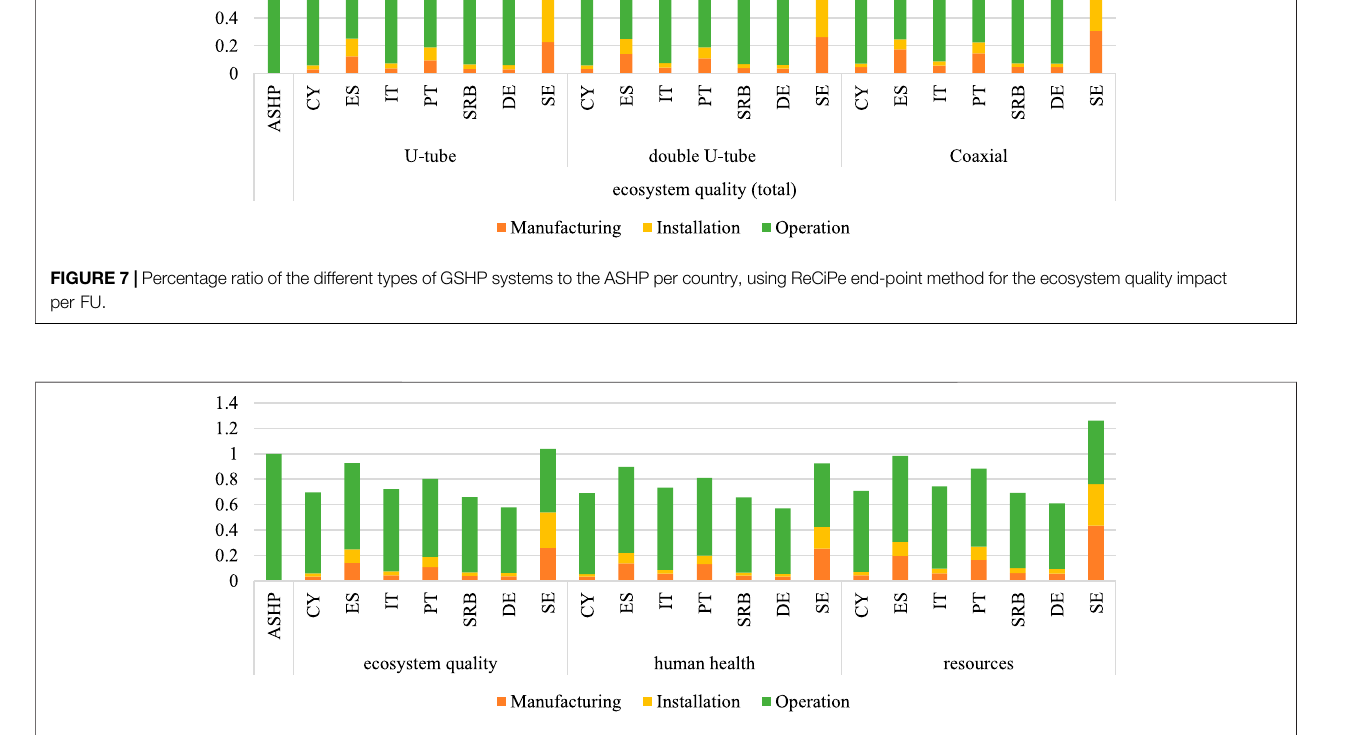
FIGURE8| PercentageratioofthedoubleU-tubeGSHPsystemtotheASHPpercountry,usingReCiPeend-pointmethodforallthreedamagecategoriesperFU.